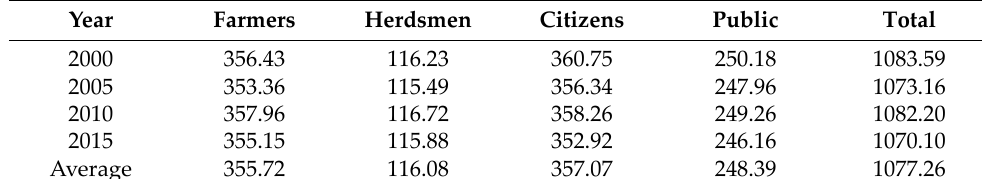
Table 8. HWV of different stakeholders in the basin from 2000 to 2015 (10 8 ¥).